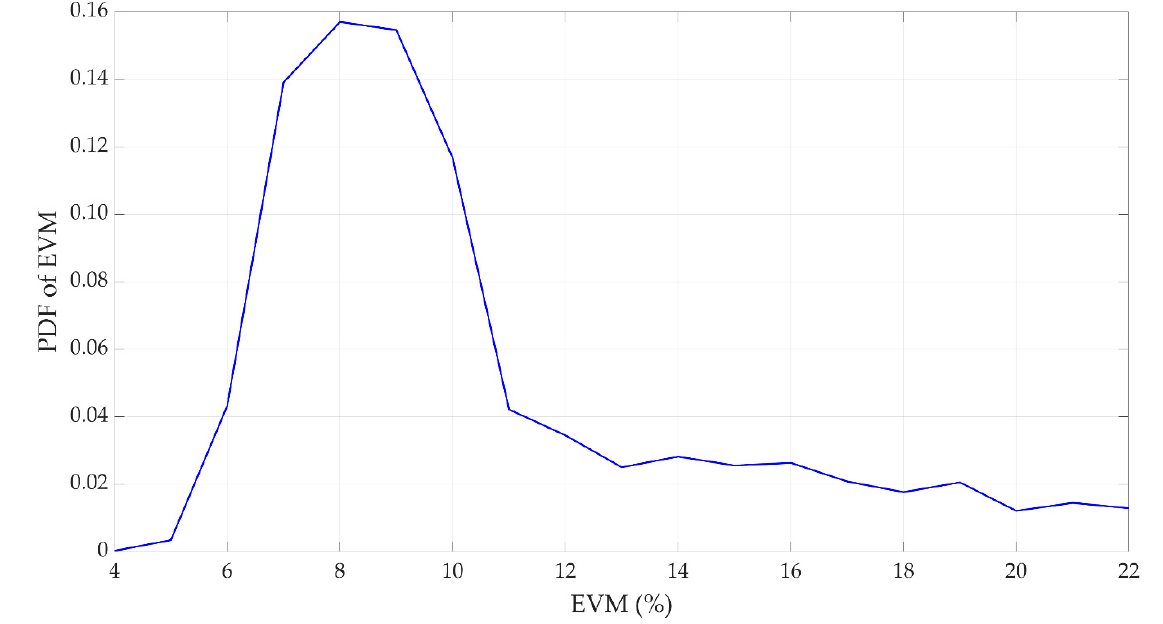
Figure 18. Covert signal detection results: probability density function (PDF) of EVM.